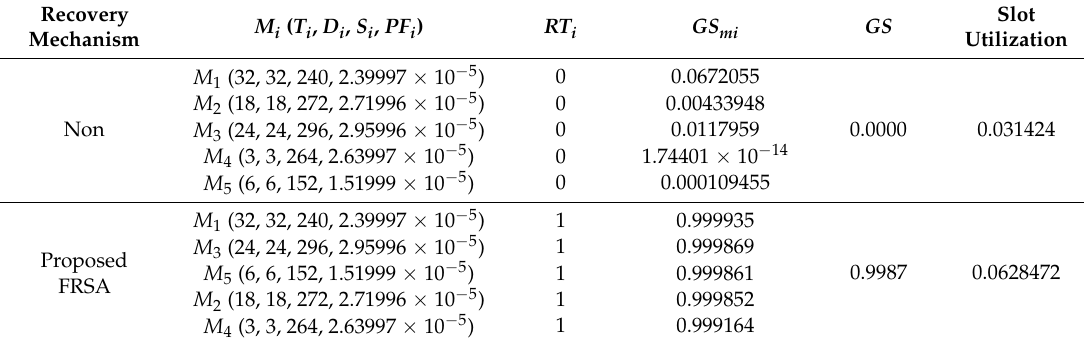
Table 1. The validation of the proposed